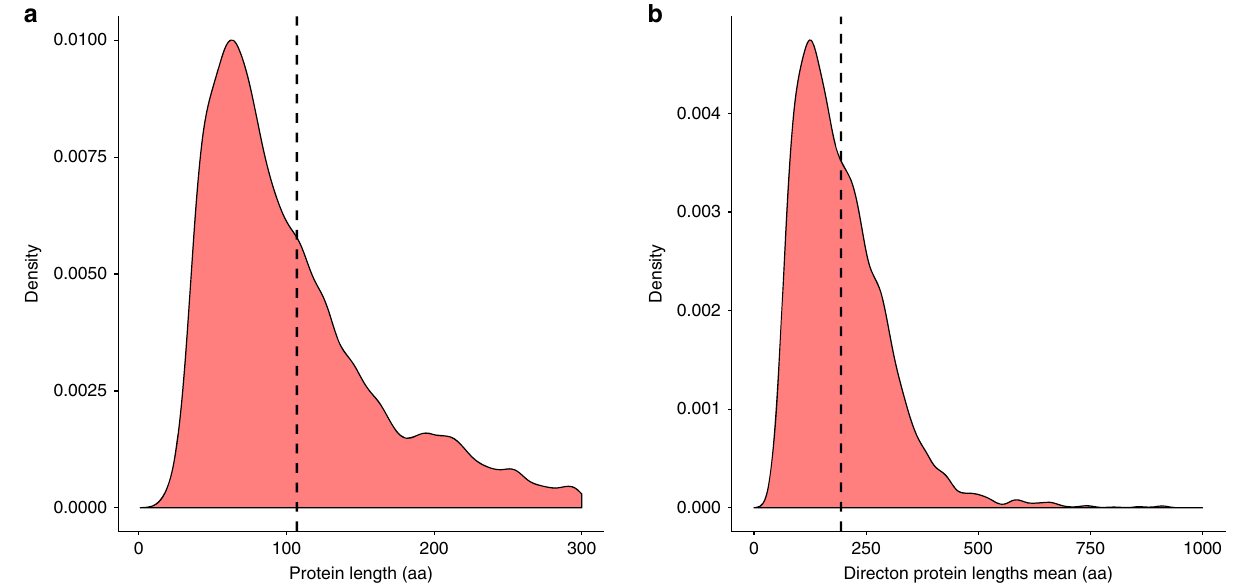
Fig. 5 Protein length distribution of the Acr candidates. a Density plot of the protein lengths of the predicted Acrs. The mean value (109 aa) is indicated with a dashed line. b Density plot of the mean protein lengths in the predicted Acrs directons. The mean value (200 aa) is indicated with a dashed line.